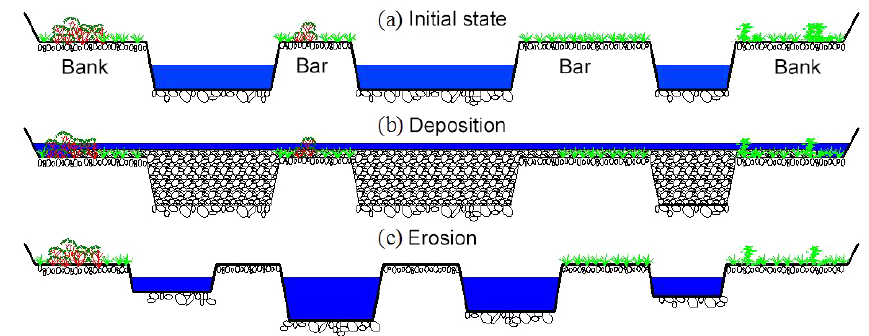
Figure 6. Sketch of channel bed deposition and erosion in flood season in the Dari reach.